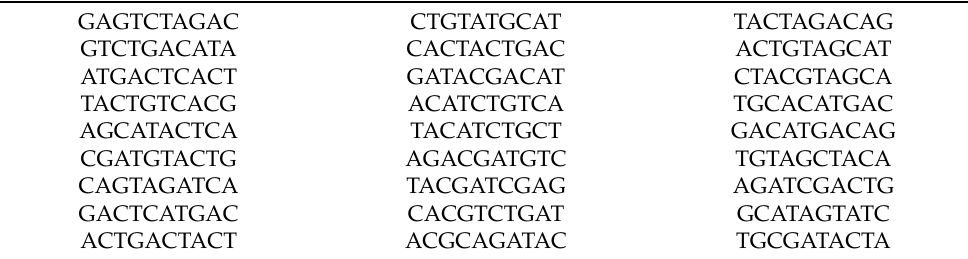
Table 4. DNA coding sets for DNA library L k ( n ) retrieved when n = 10 and d =